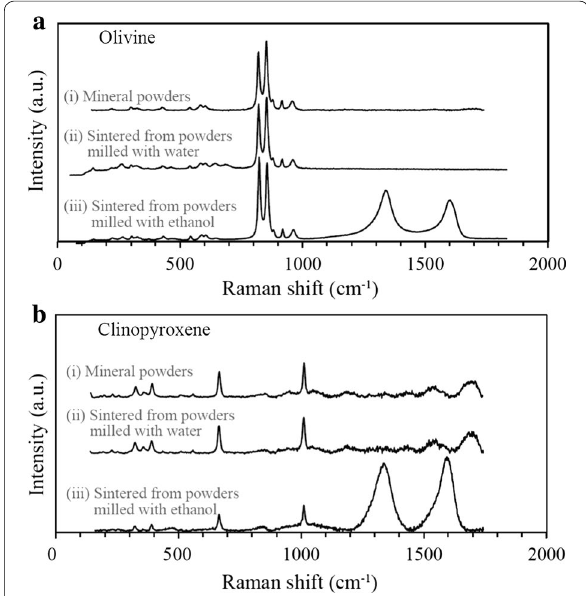
Fig. 4 Raman spectra of mineral powders and samples that were sintered at 1300 °C for a olivine and 1180 °C for b clinopyroxene. (i) Mineral powders. (ii) Sintered from powders milled with water. (iii) Sintered from powders milled with ethanol. Graphite peaks were not found in sintered samples where the powders were milled using water rather than ethanol